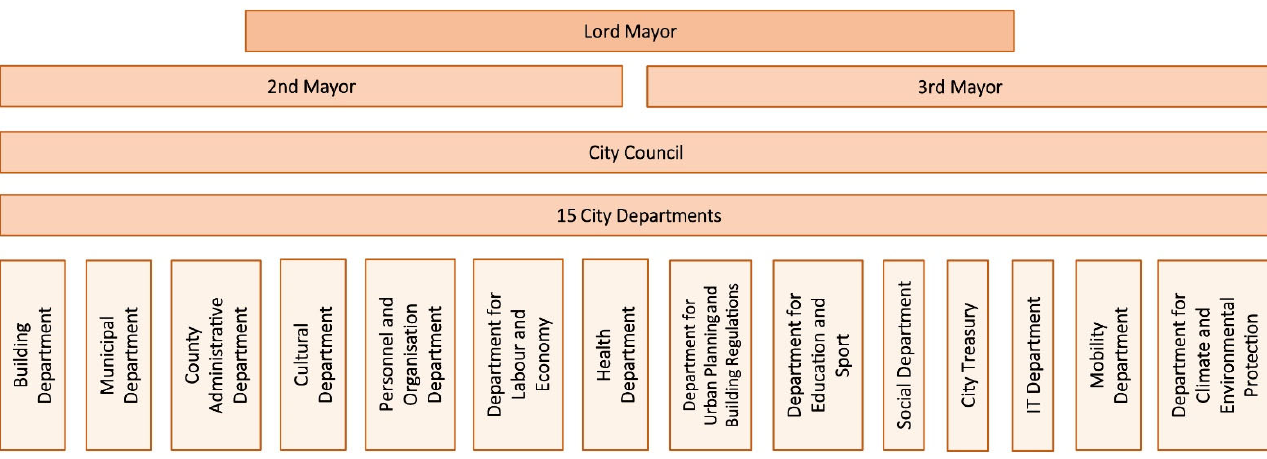
Figure 1. Higher-level management structure (Geschäftsverteilungsplan) of Munich, adapted Figure 1. Higher ‐ level management structure (Geschäftsverteilungsplan) of Munich, adapted from from [50].